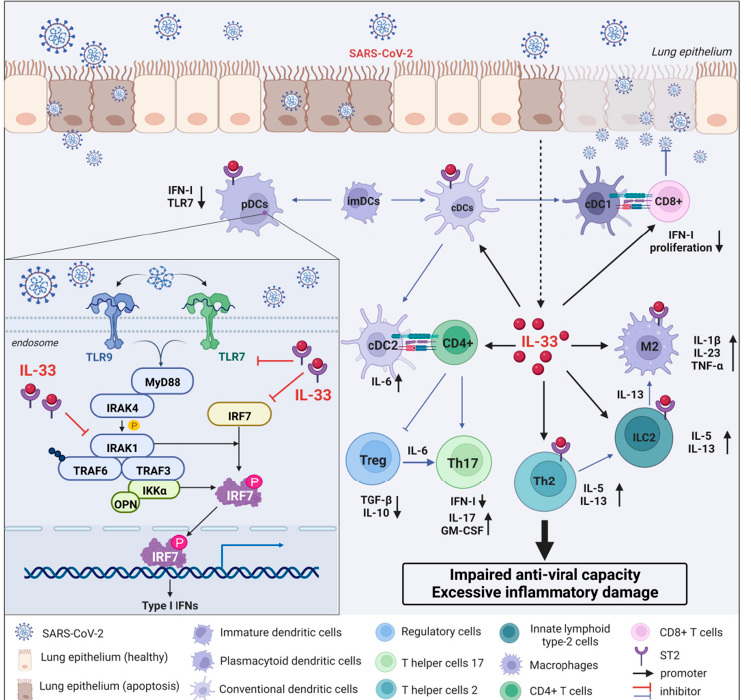
Figure 4. Interaction mechanism between IL-33 and IFN-I released by pDCs during COVID-19 infection. After the lung epithelium is infected with SARS-CoV-2, the replicating virus can cause epithelial cell apoptosis and directly damage the epithelium. Dendritic cells present antigens to helper T cells. Immature DCs differentiate into conventional DCs (cDCs) and plasmacytoid DCs (pDCs). IFN-I specificity derived from pDCs is dependent on the Toll-like receptor-7 (TLR7)/TLR9 pathway. Upon COVID-19 infection, TLR7 or TLR9 activates MyD88 and IL-1 receptor-associated kinase 4 (IRAK-4), which then interact with tumor necrosis factor receptor-associated factor-6 (TRAF6), TRAF3, IRAK1, IKK α , and interferon regulatory factor 7 (IRF7) interaction. Ultimately, IRAK-1 and IKK α phosphorylate IRF7, leading to IRF7 activation and induction of IFN-I gene transcription and massive IFN-I production. Additionally, IL-33, an important inflammatory storm cytokine, is abundantly released from apoptotic epithelial cells and inhibits pDC-dependent IFN-I by rapidly depleting the intracellular adaptor molecules IRAK1 and viperin, resulting in a hyporesponsive state of TLR7. Meanwhile, IL-33 induces the expression of a large number of cytokines by interacting with immune cells, such as macrophages, ILC2 cells, Th2 cells, Th17 cells, and Treg cells, which ultimately leads to abnormal inflammatory damage and decreased antiviral capacity in COVID-19 patients.